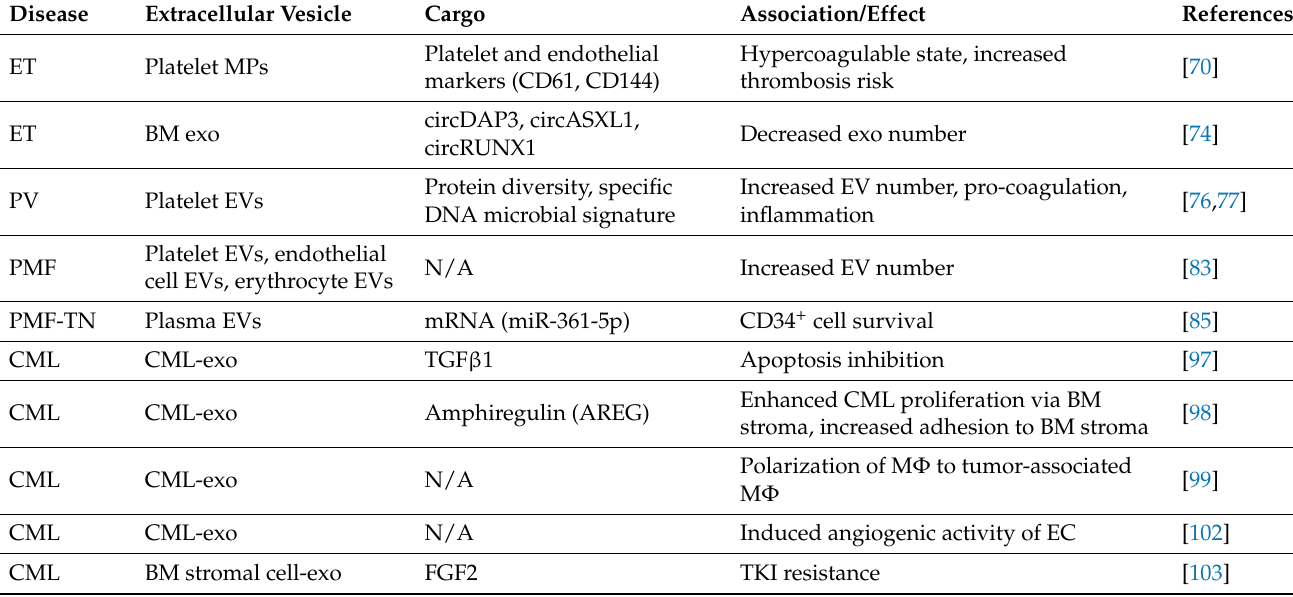
Table 1. Summary of findings related to the role of extracellular vesicles in myeloid malignancies. Disease Extracellular Vesicle